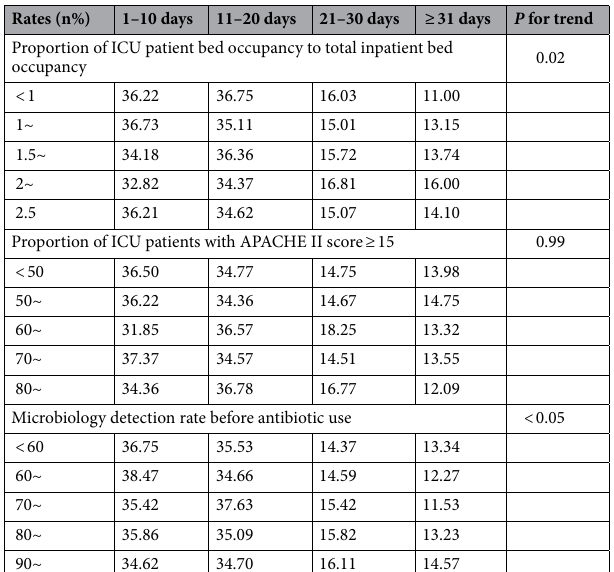
Microbiology detection rate before antibiotic use